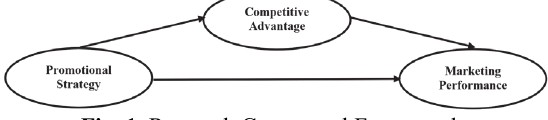
Fig. 1. Research Conceptual